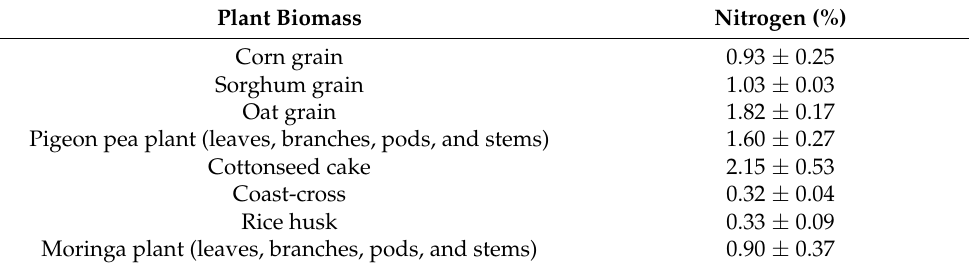
Table 1. Mean value nitrogen content of each biomass used for substrate formulation.